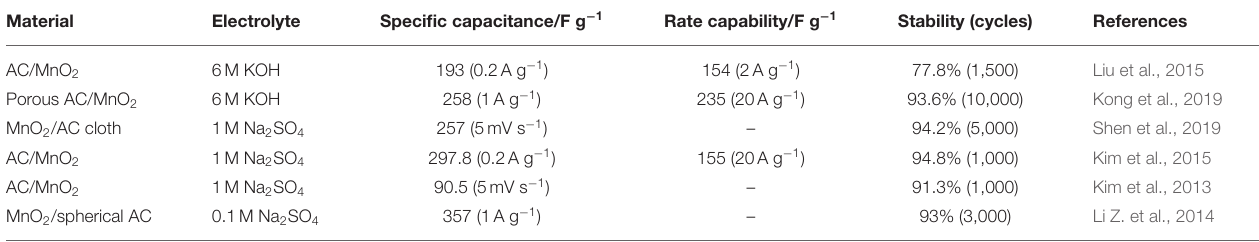
TABLE 4 | Electrochemical performance of various MnO 2 /CNT material.